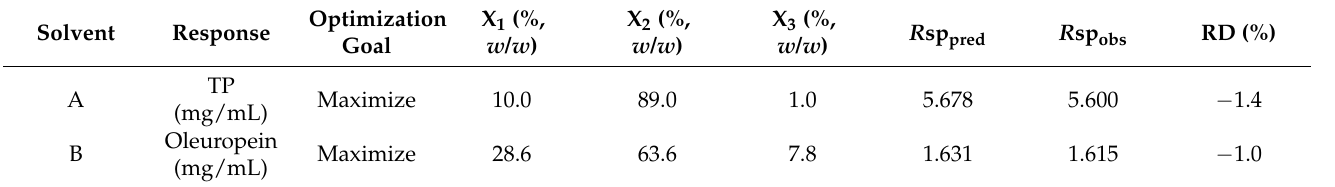
Table 3. Comparison of the predicted and experimental values for the optimized